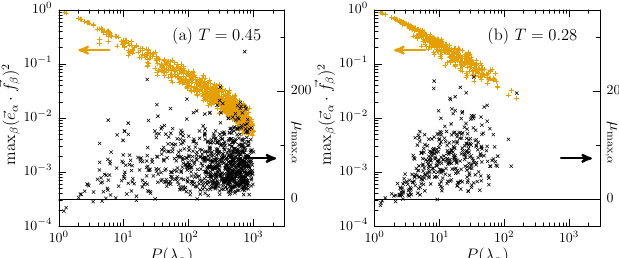
Figure 8: PDF of the eigenvalues of the one-particle dynamical matrix. All parameters are the same as in Fig. 7.